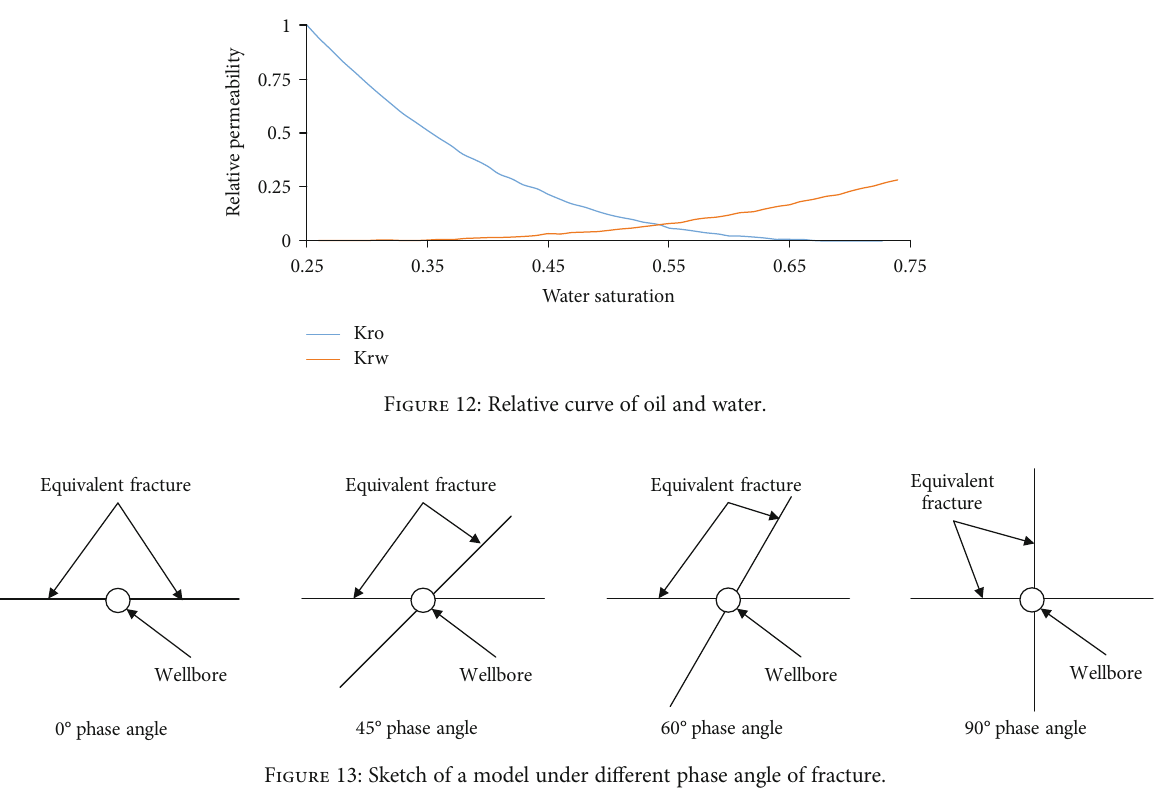
Figure 13: Sketch of a model under di ff erent phase angle of fracture.